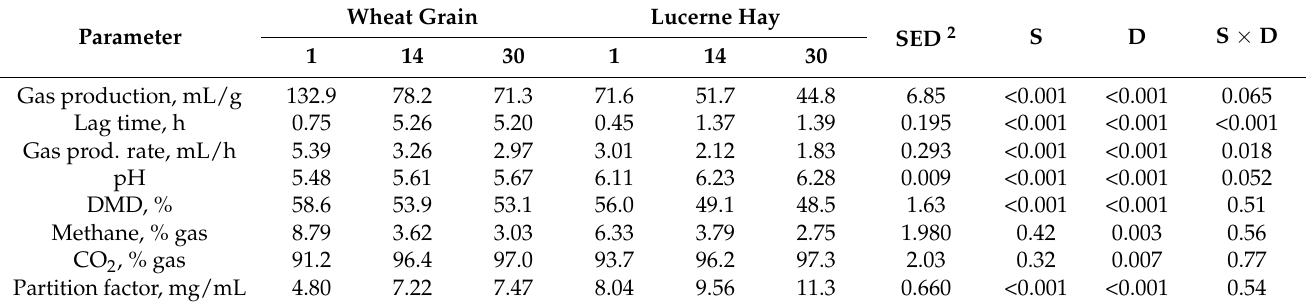
Table 2. The effects of feedstuffs (wheat grain vs. lucerne hay) and rumen fluid storage days (14 days